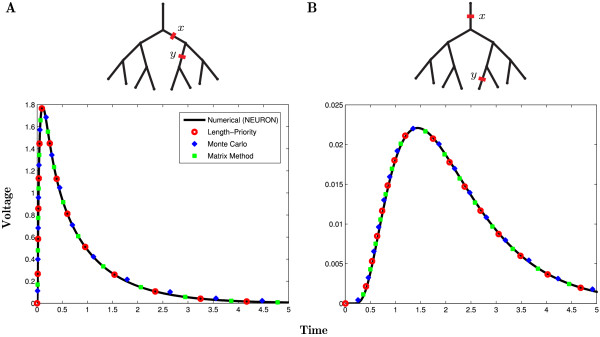
The Green’s function constructed by a number of methods. The voltage traces show the analytical solutions Gij(x,y,t) for fixed x and y on a binary tree for the length-priority method (red circles), the Monte-Carlo method (blue diamonds) and the matrix method with kmax=100 (green squares) superimposed on NEURON’s numerical solution (black line). Parameter set A (Table 1) is used in these computations